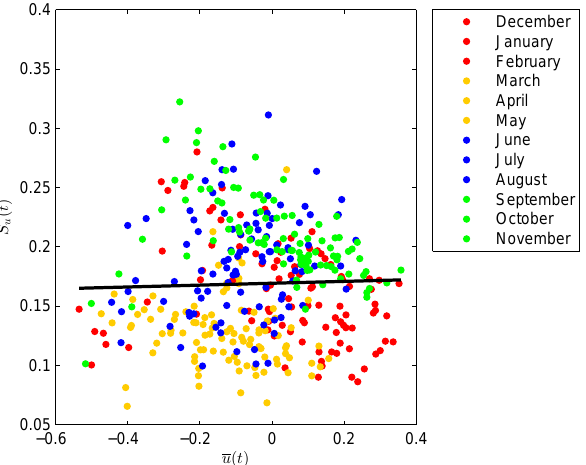
Figure 6. Spatial standard deviation, S u ( t ), vs. the spatial mean, u ( t ), of the transformed data { u ( s ,t ) } , in the Niño 3.4 region, for all t ∈ D t , with the WTS-estimated line superimposed. Each season has a different colour (DJF points are red; MAM points are yellow; JJA points are blue; SON points are